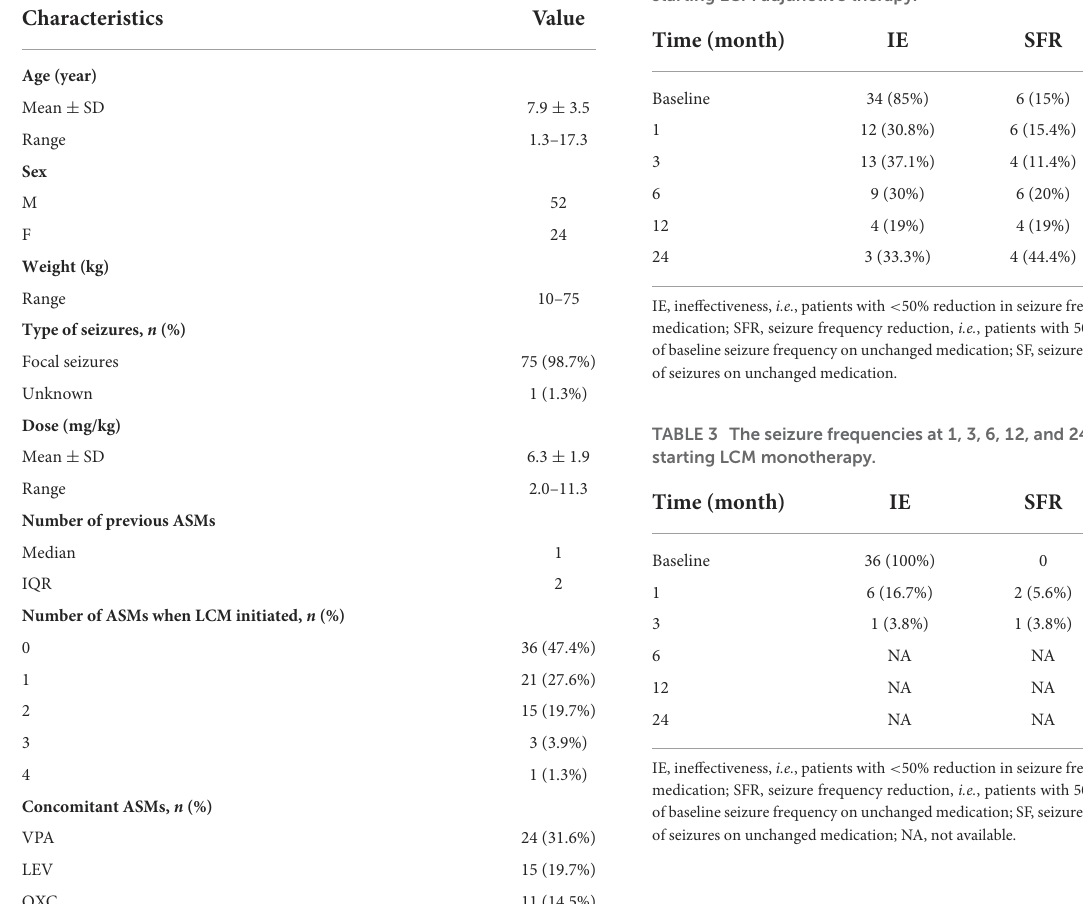
TABLE 1 Clinical characteristics of